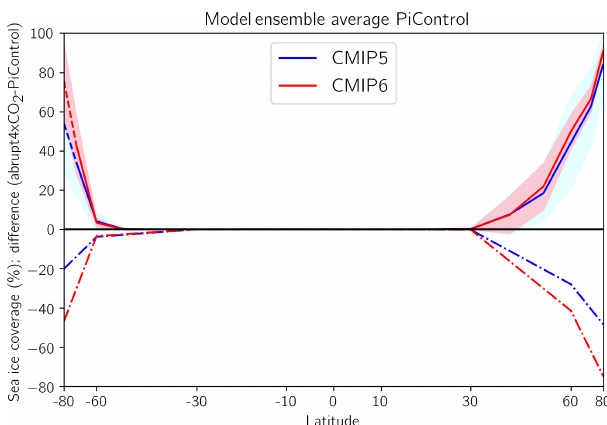
Figure 7. Zonal average sea ice coverage from piControl for the CMIP5 ensemble (blue) and CMIP6 ensemble (red) shown as solid red and blue lines; dashed lines in these curves indicate regions where difference in mean sea ice coverage is statistically significant ( p < 0 . 05). Light blue and red shading around the solid lines repre- sent SD of each ensemble. Dashed-dotted lines represent the aver- age difference in sea ice coverage between the zonal average piCon- trol simulation (over the 150 years corresponding to abrupt4xCO2 ) and the mean of the last 30 years of the abrupt4xCO2